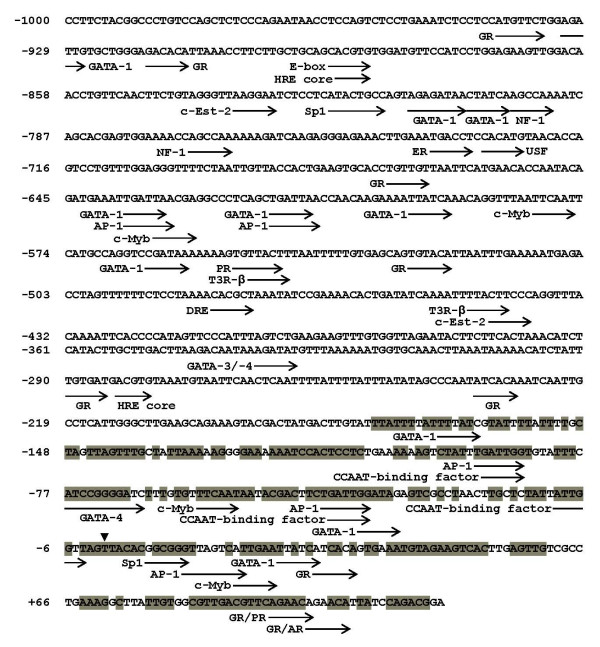
The 5'-flanking sequence of omTERT. Numbers on the left denote the nucleotide positions relative to the transcription start site (designated as +1 and indicated by an inverted triangle). Positions of putative transcription factor binding sites are marked with arrows underneath. The 177-bp sequence in the omTERT promoter which is conserved also in the 5'-flanking sequence of the O. latipes TERT promoter is shaded in gray.